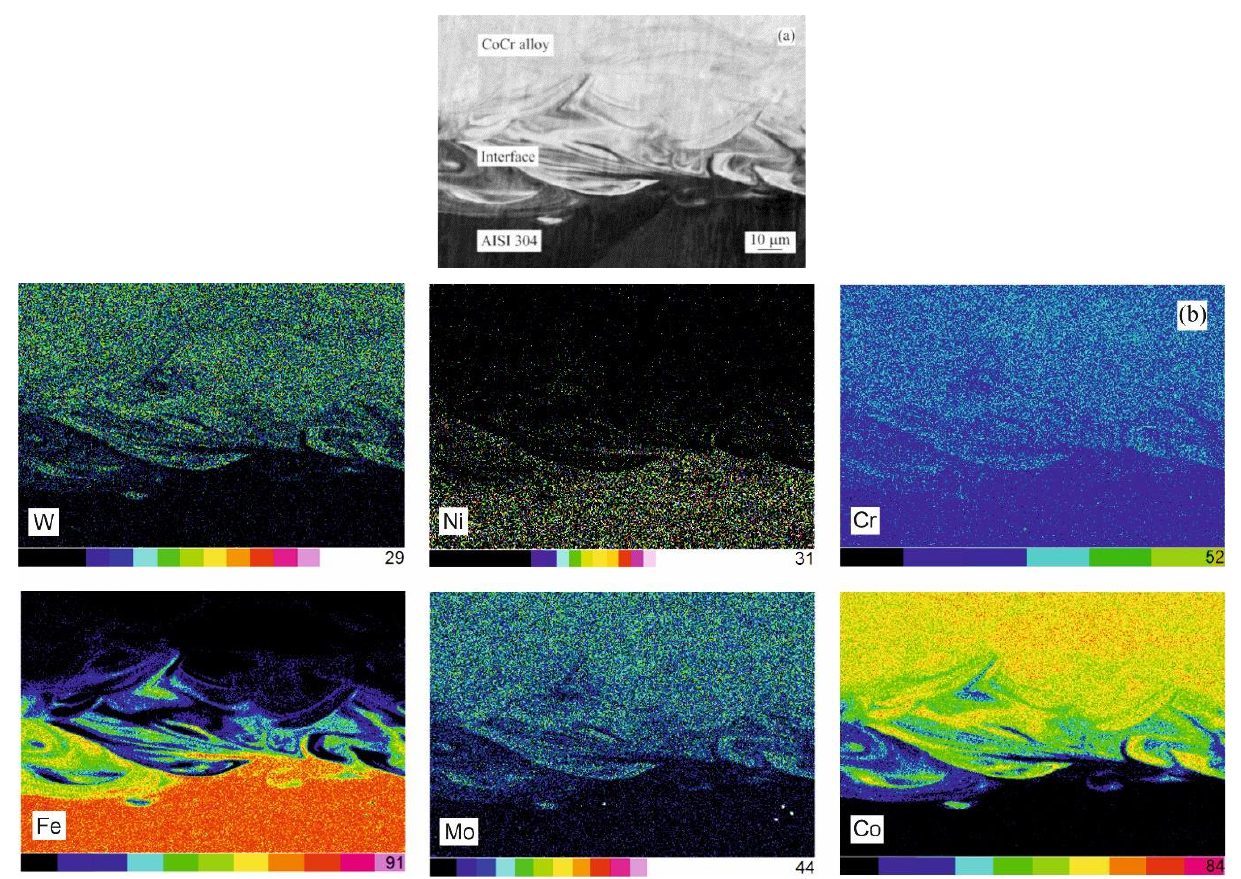
Figure 12. CoCr – 304 interface maps based on main chemical elements (in wt.%) and their distribu- Figure 12. CoCr–304 interface maps based on main chemical elements (in wt.%) and their distribution: tion: ( a ) SEM image; ( b ) EDAX maps for W, Ni, Cr, Fe, Mo, and Co. ( a ) SEM image; ( b ) EDAX maps for W, Ni, Cr, Fe, Mo, and Co. Table 5. EDAX point measurement data for sites indicated in Figure 13. Red color indicates CoCr alloy composition; blue color indicates 304 stainless steel composition.